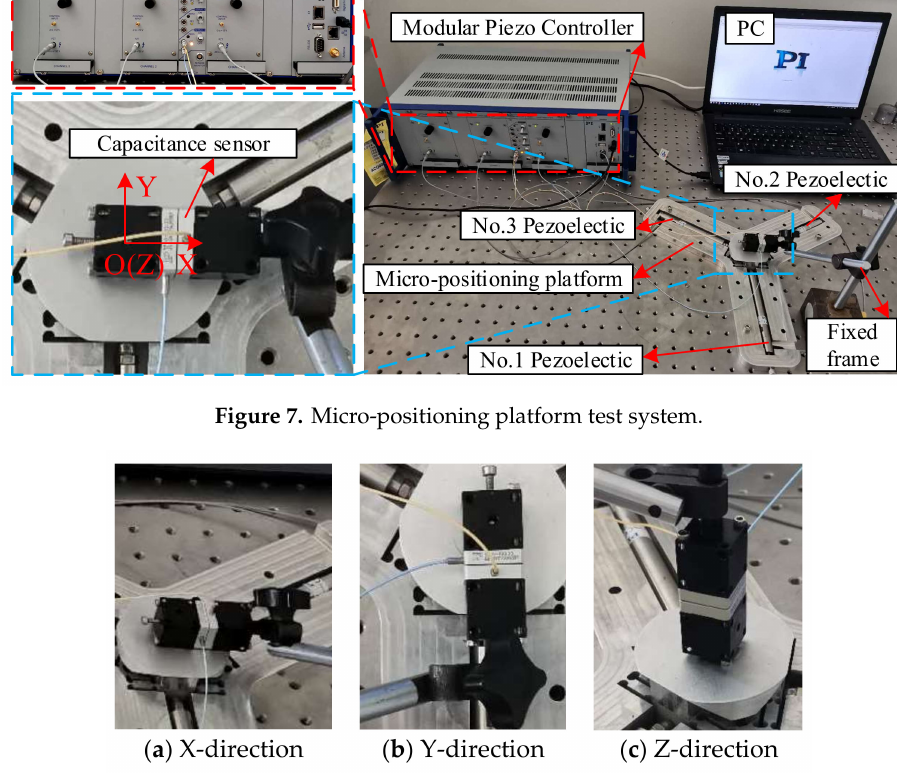
Figure 8. Capacitive sensor installation in all